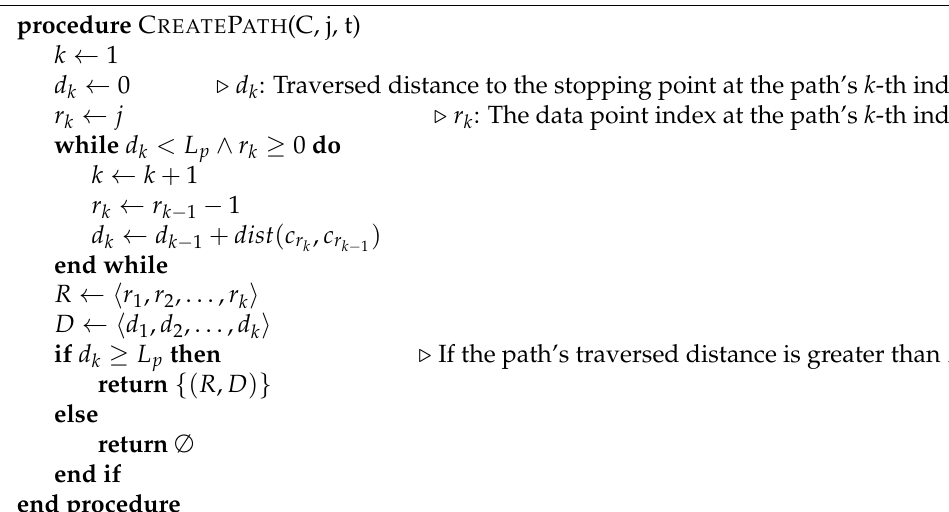
Algorithm 2 Creating a path given its closest point to the traffic